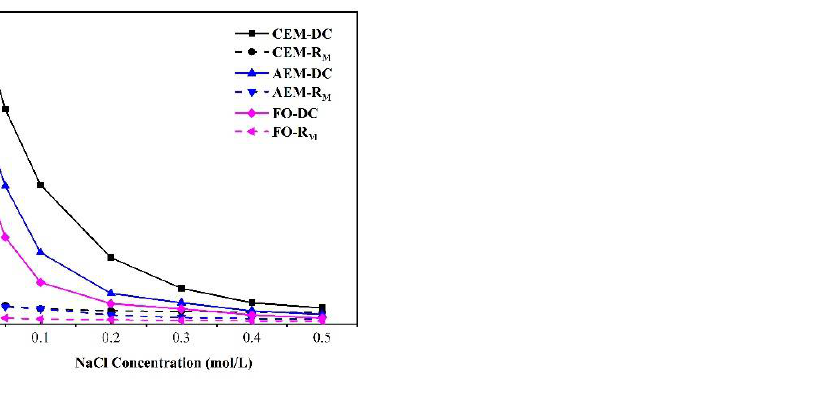
Figure 12. Relationship between the membrane impedance measured by the DC and AC approaches and the concentration of the external salt solution.